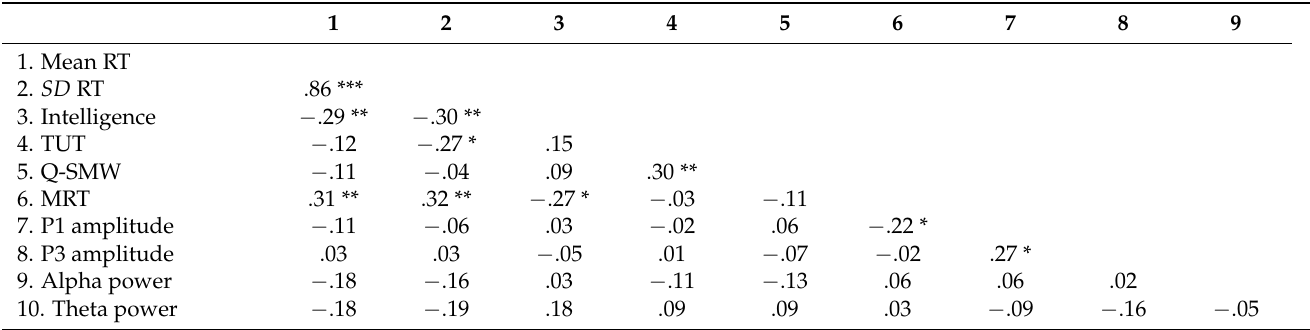
Table 2. Correlations between all